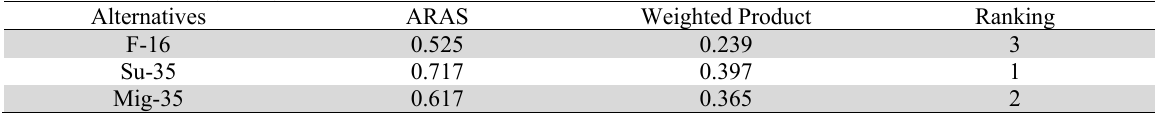
The result of sensitivity analysis ARAS and WP